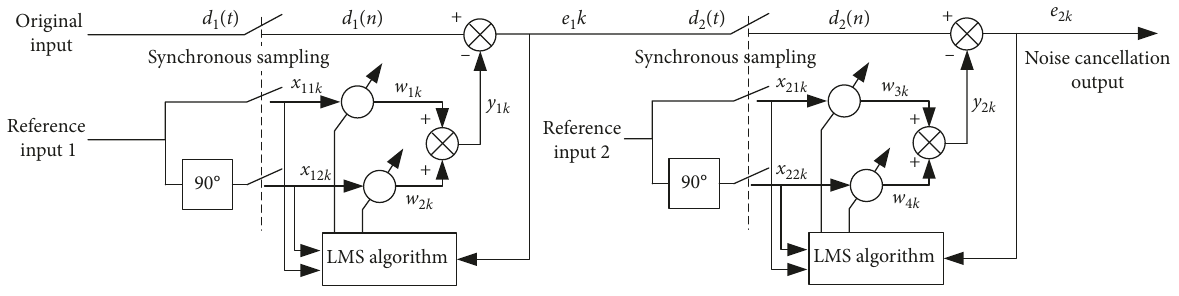
Figure 4: Multifrequency adaptive notch filter.